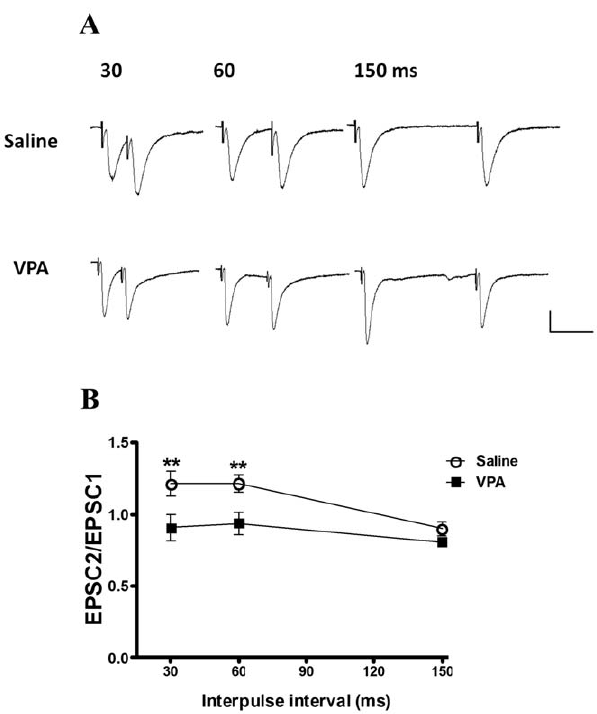
Figure 4. Paired-pulse facilitation (PPF) in the LA neurons of the VPA offspring. (A) Sample traces of PPF in the saline (n=10) and VPA (n=15) offspring. (B) Plot of PPF for 30-, 60-, and 150-ms interpulse intervals at the thalamic–amygdala synapse. **p , 0.01; scale 50 ms, 40 pA.